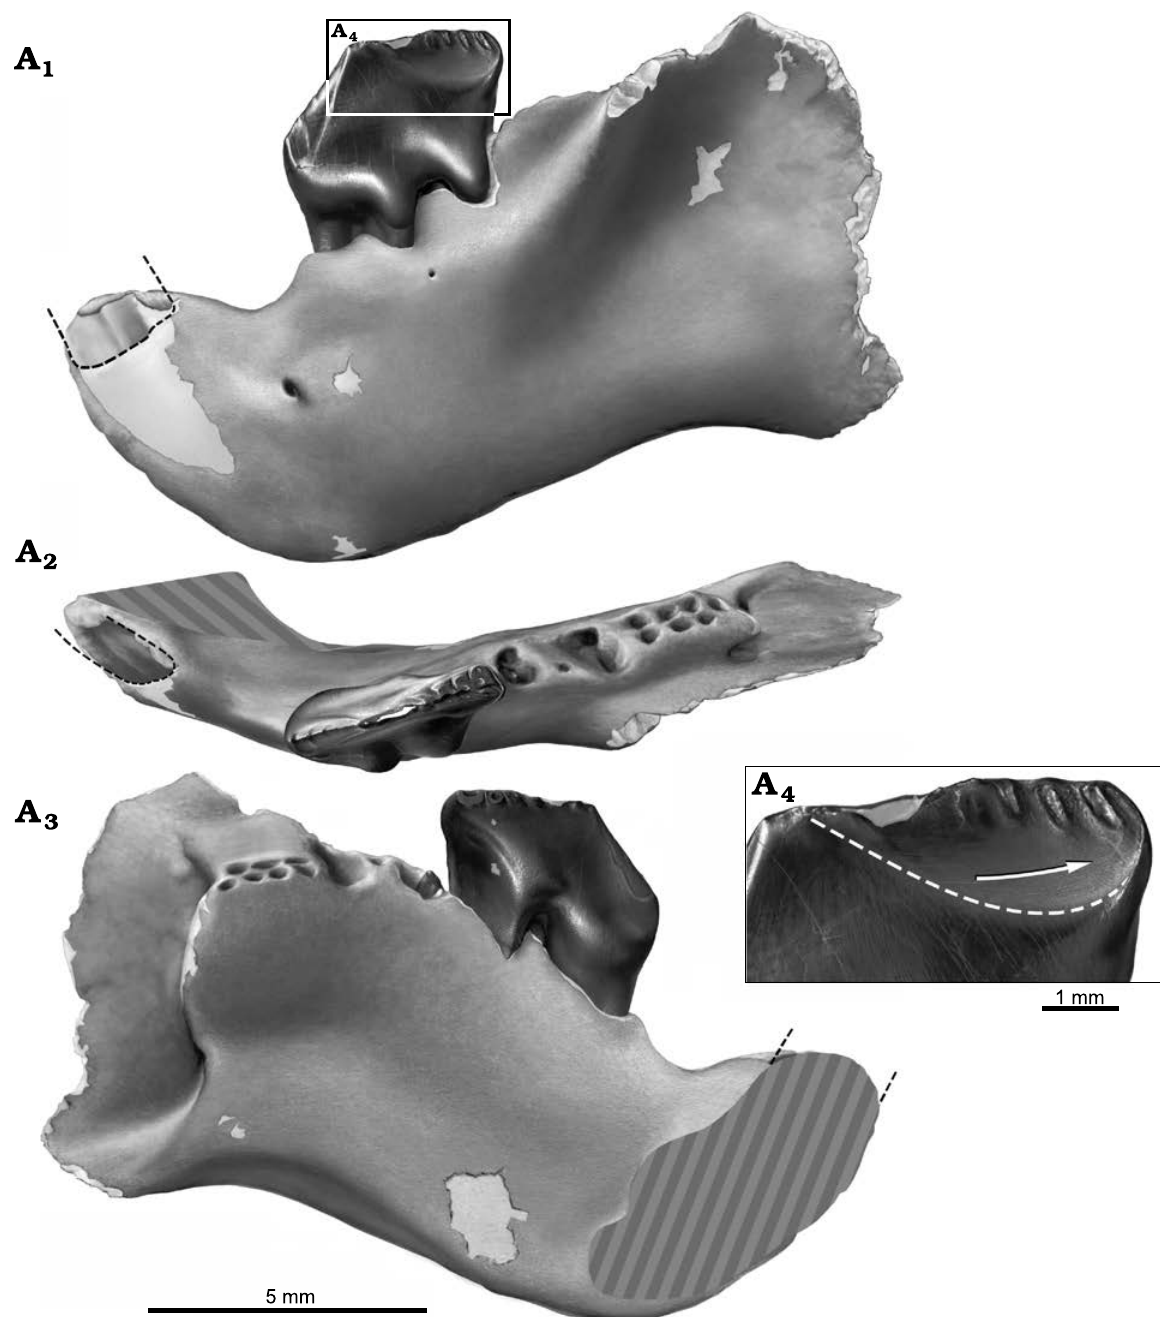
Fig. 5. Reconstruction of partial left dentary with p4 in situ, NMV P252730, of the cimolodontan multituberculate Corriebaatar marywaltersae Rich, Vickers-Rich, Flannery, Kear, Cantrill, Komarower, Kool, Pickering, Trusler, Mor ton, van Klaveren, and Fitzgerald, 2009, Flat Rocks locality, Eumeralla Formation, Barremian, Lower Creta ceous of Victoria, Australia. Specimen in lateral (A 1 ), dorsal/occlusal (A 2 ), and medial (A 3 ) views. Size and shape of base of crown of lower incisor indicated by black dashed lines. Estimate of size and position of symphyseal area indicated by gray hatching in A 2 and A 3 . Buccal view of distal portion of p4 (A 4 ), illustrating abraded distobuccal wear facet, the lower limit of which is indicated by white dashed line. Buccal ridges are preserved as elliptical troughs of enamel surrounded by the abraded wear surface. Arrow indicates the slightly curved orientation of wear stri- ations and the direction of palinal movement of p4 relative to the upper dentition. Artwork by Peter